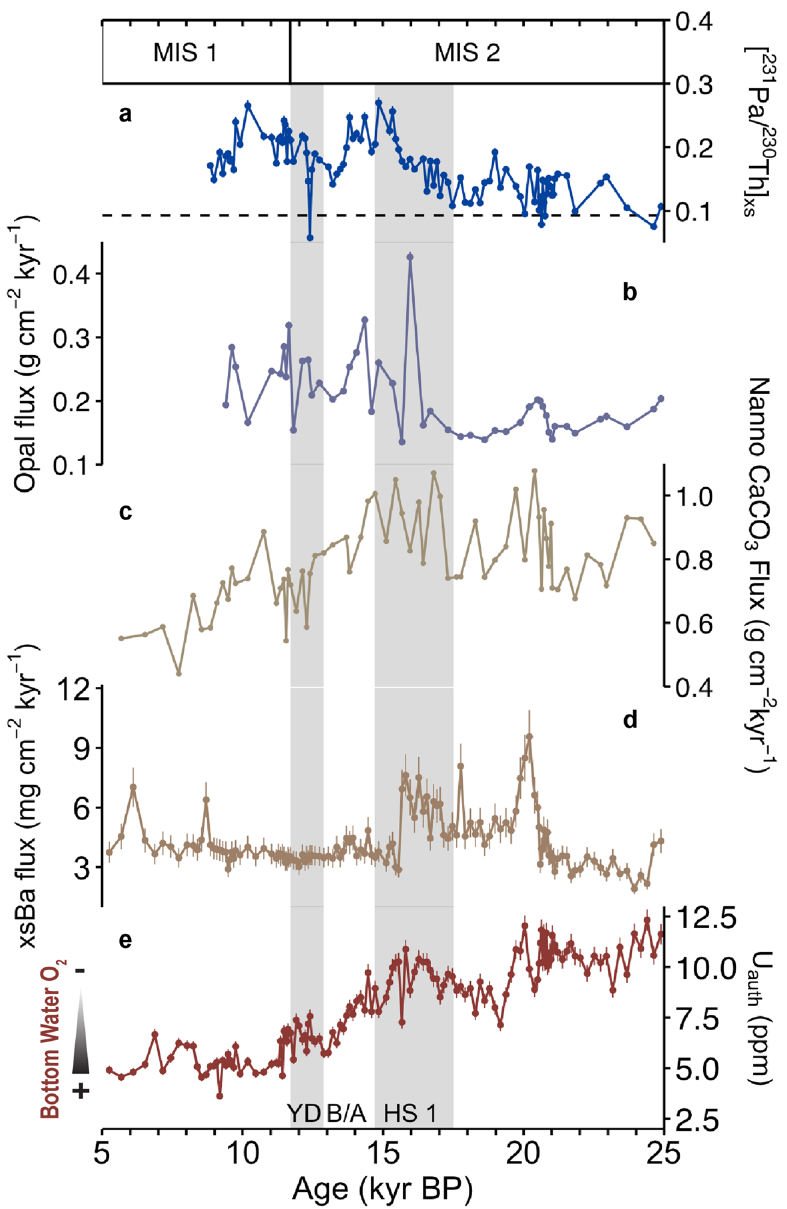
Figure 3. Proxy records of export production and bottom water oxygenation state at 17JC shown with MIS boundaries from Lisiecki and Raymo 70 and HS1, B/A, and YD boundaries from McManus et al. 29 (grey shaded bars represent cold stadials). ( a ) Initial [ 231 Pa/ 230 Th]xs and the 231 Pa/ 230 Th production ratio of 0.093 (dashed black line), ( b ) 230 Th-normalized opal fluxes, ( c ) 230 Th-normalized nannofossil carbonate fluxes, ( d ) 230 Th-normalized xsBa (organic matter) fluxes 11 , and ( e ) Authigenic uranium (Uauth) concentrations 11 , a proxy for bottom water oxygenation. Lines through data points represent error bars (see methods); those not visible are smaller than the data